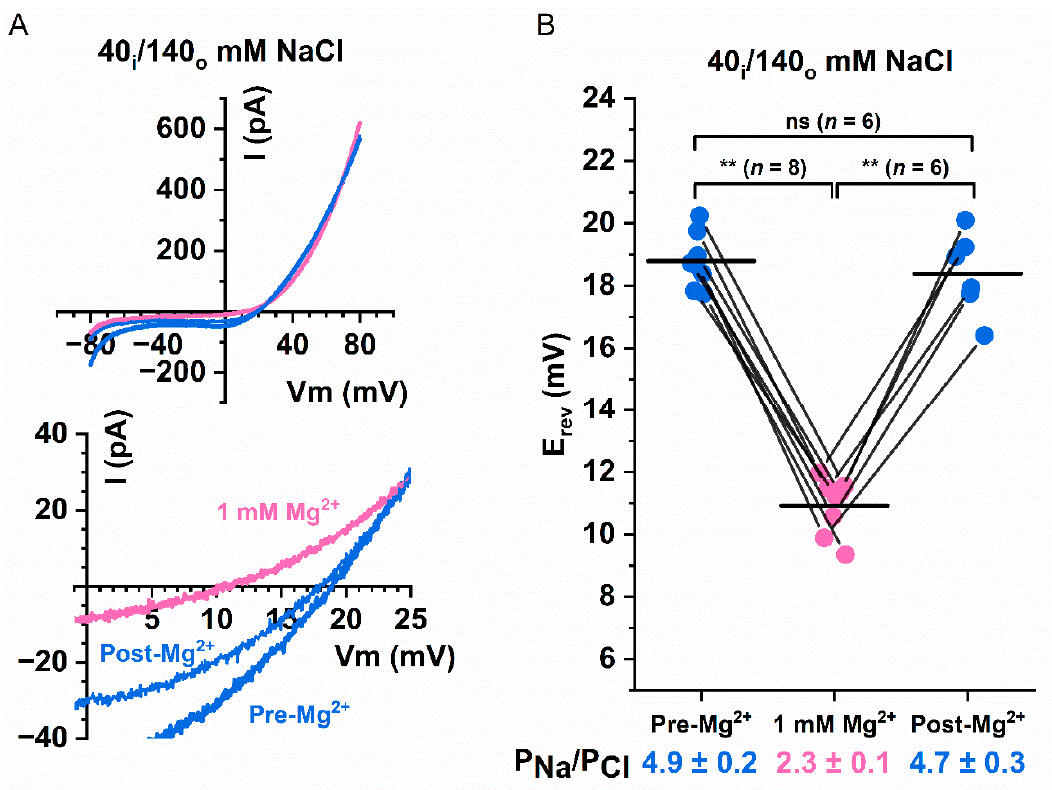
Figure 9. Effects of [Mg 2+ ] i on the P Na /P Cl ratio of Q559W 16F . ( A ) Representative I–V curves of Q559W 16F under asymmetrical [NaCl] in the presence and absence of 1 mM Mg 2+ . Currents were activated by 20 µM [Ca 2+ ] i . Bottom panel shows the same I–V curves expanded around E rev . ( B ) Paired data showing the values of E rev in the presence (pink circles) of 1 mM Mg 2+ , and the values of E rev before Mg 2+ wash-in and after Mg 2+ wash-out (blue circles). Horizontal black lines indicate the mean value for each data set. Calculated P Na /P Cl ratios are shown at the bottom of the plot. ns p > 0.05; ** p < 0.005 by one-way ANOVA followed by Bonferroni’s multiple comparisons.